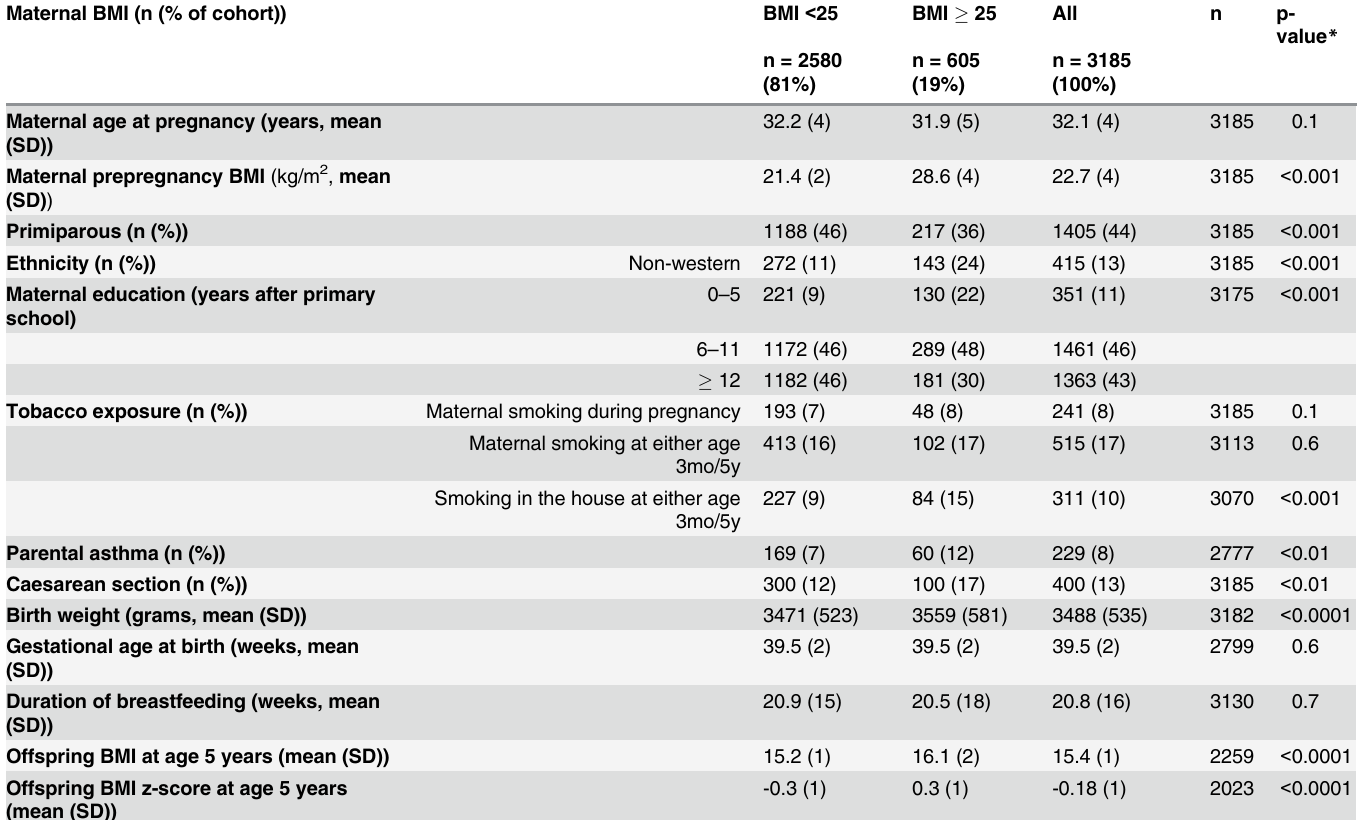
Table 1. Differences in demographics (mean or prevalence), as a function of prepregnancy BMI in mothers and their offspring (n = 3185) ^ . Maternal BMI (n (% of cohort))